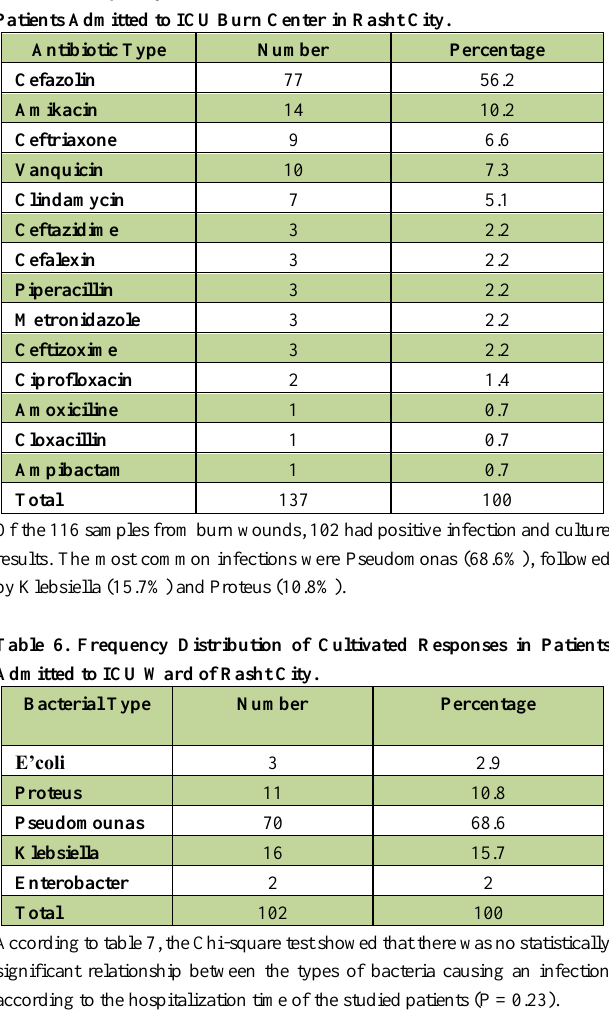
Table 5. Frequency Distribution of Pre-Cultivated Antibiotics in